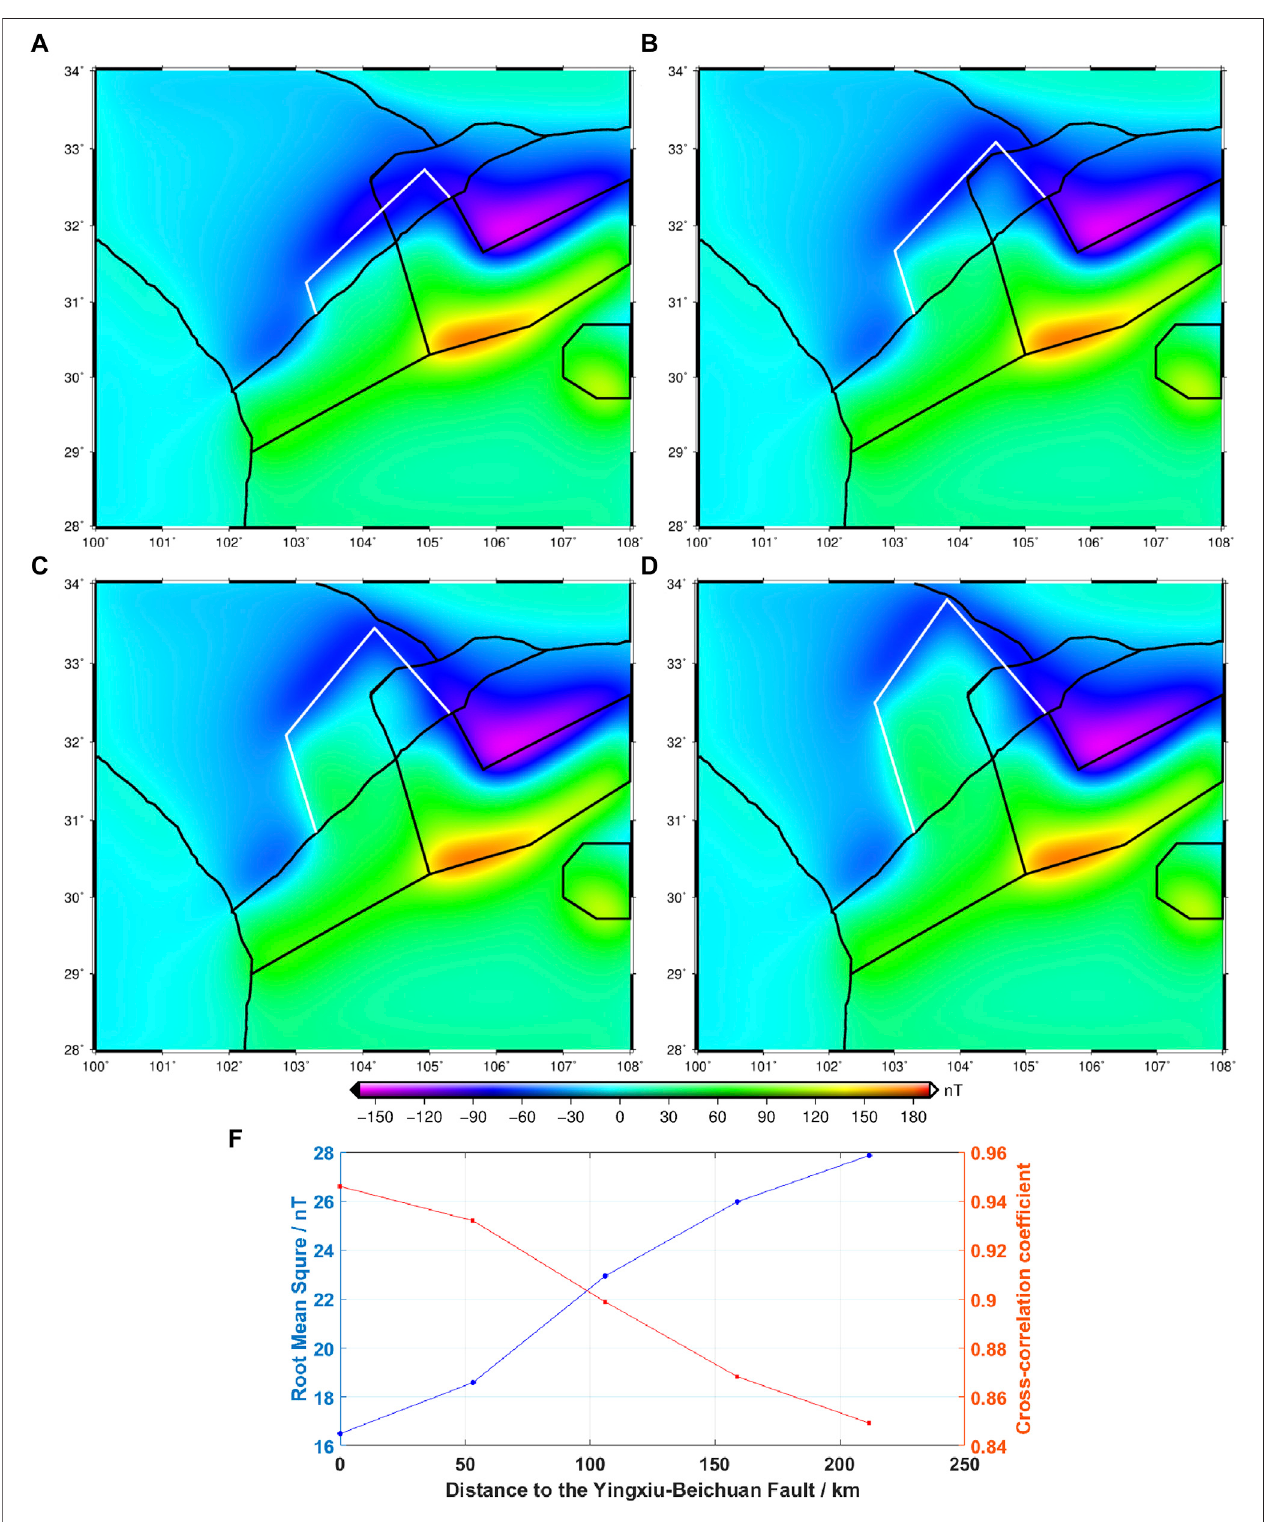
FIGURE 10 | Calculated anomalies generated by models with different west margin corresponding to (A) 53 km; (B) 106 km; (C) 158 km; (D) 211 km from the YXBCF.Blacklinesarethesame boundariesofmagneticblocks as Figure9 .Whitelines markthewestmargin ofblock5and6. (F) Variedstandarddeviation(blue)and cross-correlation coef fi cient (red) with different boundary marked by white lines.